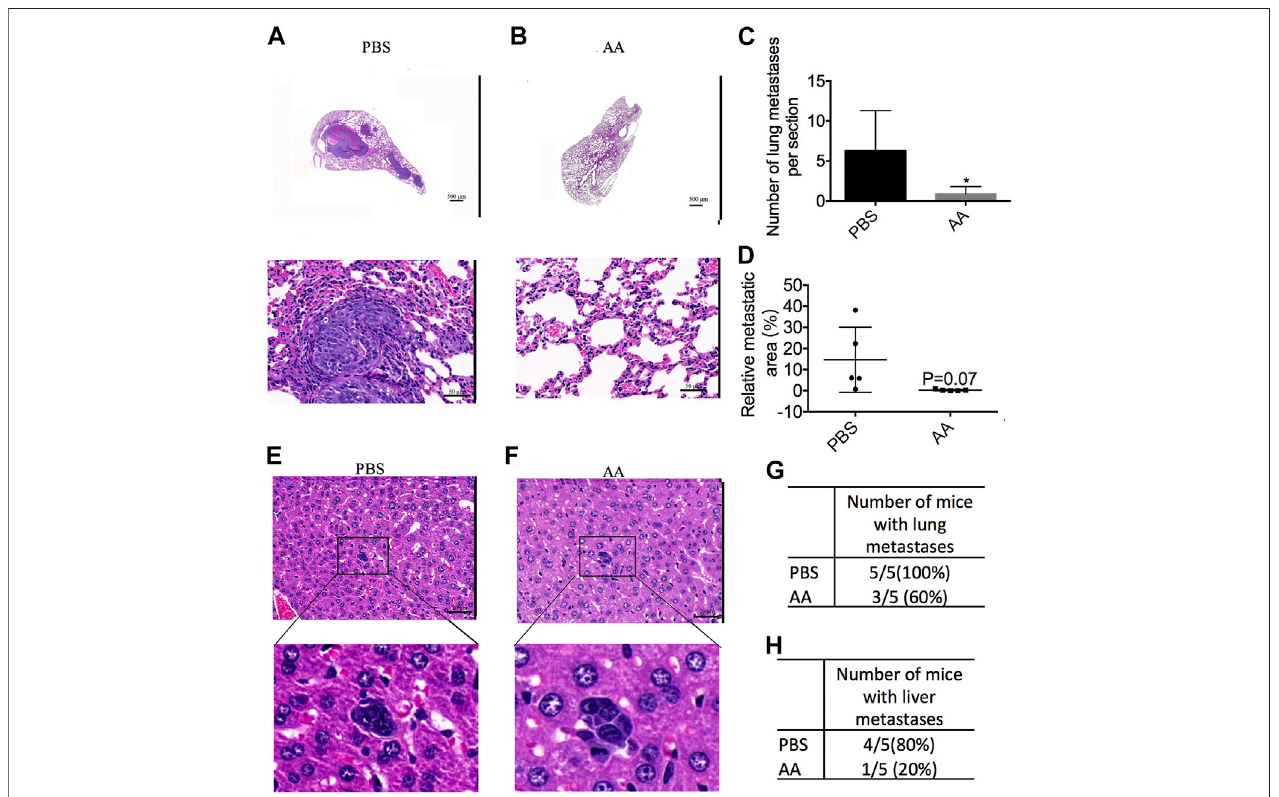
FIGURE4 | AApreventstumor metastasis in vivo .2 × 10 6 Huh7 cells were inoculated subcutaneously intofemale BALB/cnude mice. After3 weeks,PBS(control group) or 4 g/kg AA was injected intraperitoneally twice daily. At the end of the experiment, the animals were sacri fi ced to examine liver and lung metastasis. (A , B) HE stainingoflungsection(A:controlgroup,B:AAgroup;A,Bupper:2 × magni fi cation;A,Blower:40 × magni fi cation). (C , D) thenumberandarearatioofmetastatictumors in each lung section. (E , F) HE stainingof liver section. (E: control group, F: AAgroup; 40 × magni fi cation). (G) Number of mice with lung metastases in each group. (H) Number of mice with liver metastases in each group. * p <